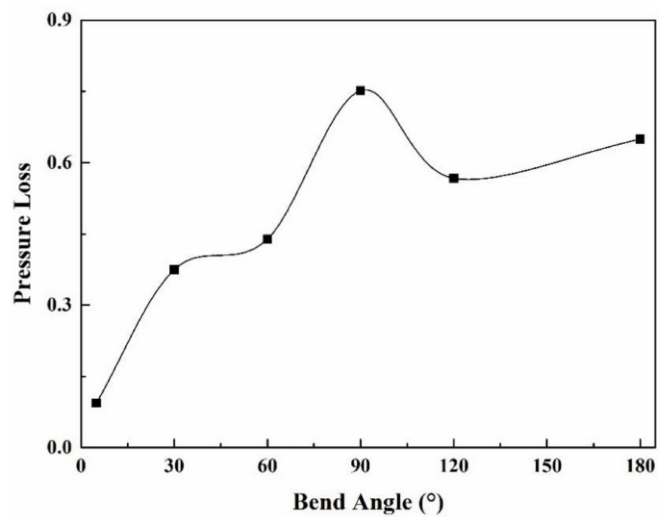
Figure 10. Pressure loss of bend pipe with different bending